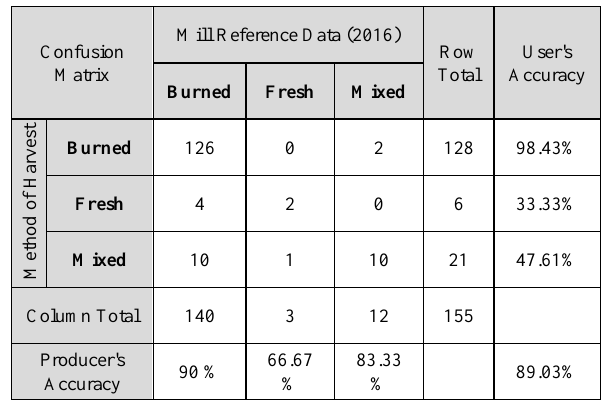
Table 3. Classification confusion matrix for the Feb-May